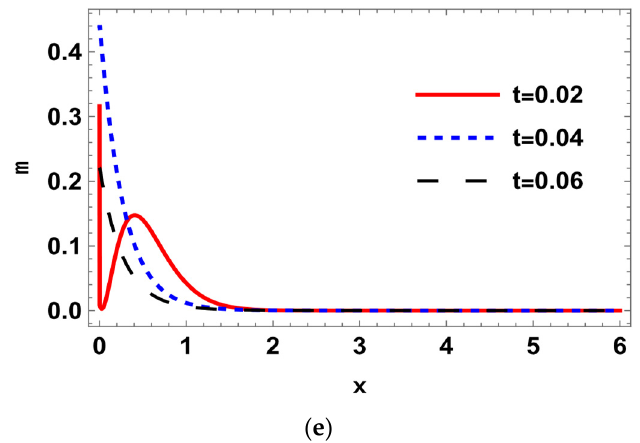
Figure 3. ( a – e ) The variance of temperature, normal stress, carrier density, displacement, and mois- ture distributions around its mean at different values of times 𝑡 = 0.02 , 𝑡 = 0.04 and 𝑡 = 0.06